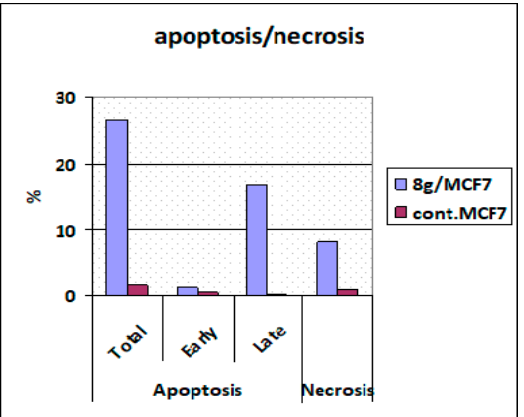
Figure 6. Percentage of apoptosis and necrosis for compound 8g in MCF-7 cell line.